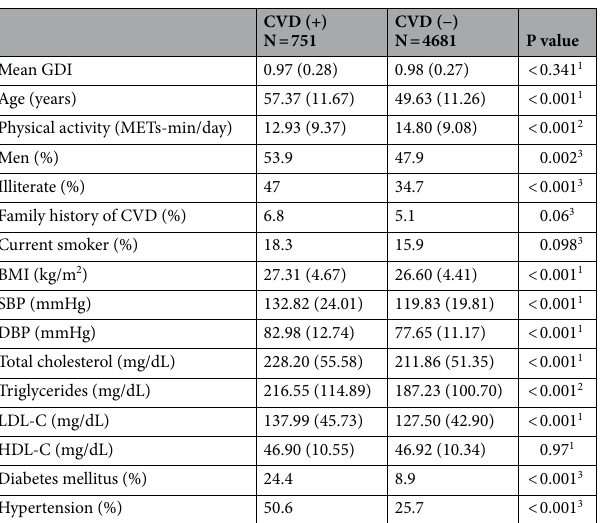
Table 2. Baseline characteristics in participants by cardiovascular disease. Data are expressed as mean (SD) or percent. GDI global dietary index, BMI body mass index, SBP systolic blood pressure, DBP diastolic blood from t-test. 2 Obtained from Mann-Withney test. 3 Frequency comparison obtained from Chi-Square.